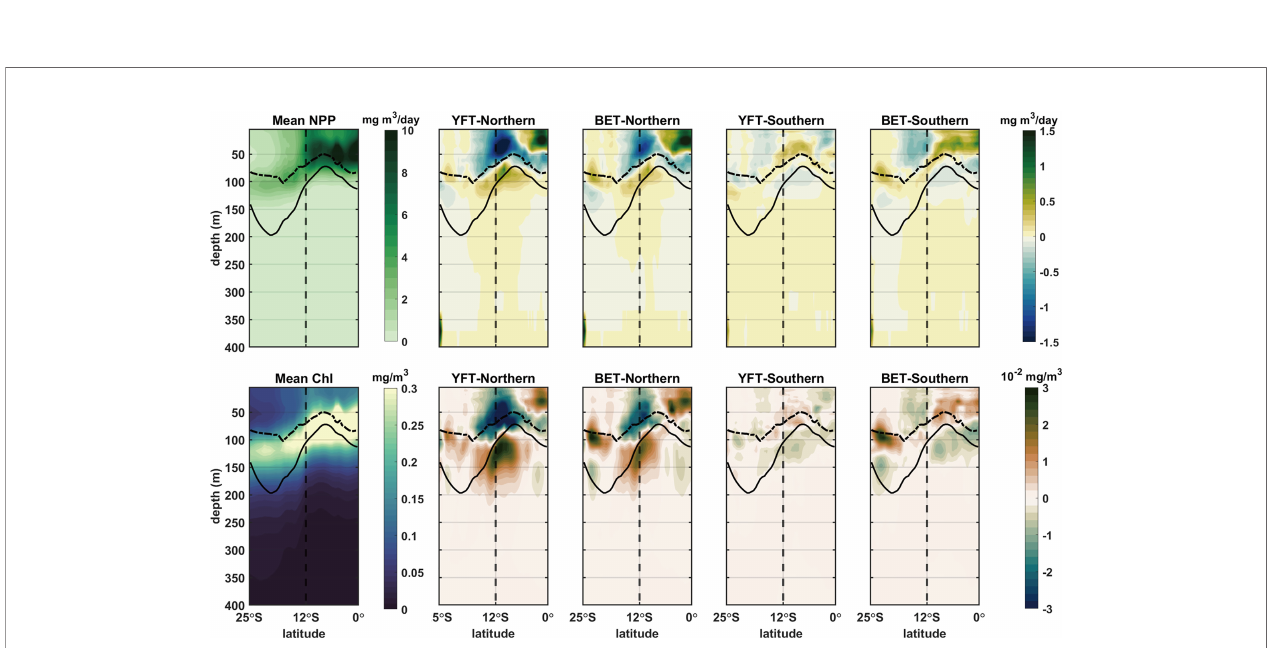
FIGURE 6 | Meridional distribution of the mean ( fi rst column) and the regressed and reconstructed anomalies of the net primary production (NPP; upper row) and chlorophyll concentration (Chl; lower row) during 1993 – 2014. Target time series are the annual catch amounts of yellow fi n tuna (YFT) and bigeye tuna (BET) in the northern (second and third columns) and southern (fourth and last columns) regions of the SWTIO. The anomalies are presented after zonal average from 54°E to 60°E. The thick dashed/dotted lines and solid lines indicate the mean thermocline depth and D20,